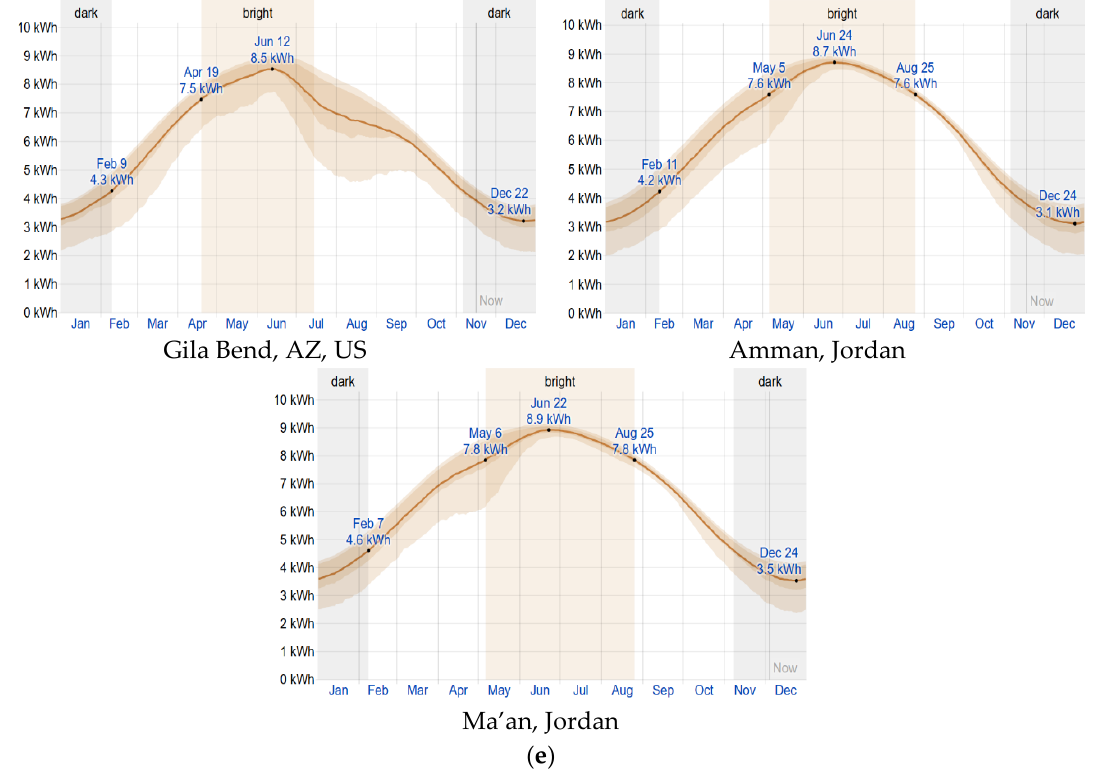
Figure 9. Weather parameters in Gila Bend, AZ, US, Amman, Jordan, and Ma’an, Jordan. Images reproduced modified from [45]. ( a ) Monthly average high and low temperatures; ( b ) clouds coverage; ( c ) hours of daylight and twilight; ( d ) humidity; ( e ) average daily incident shortwave solar energy.